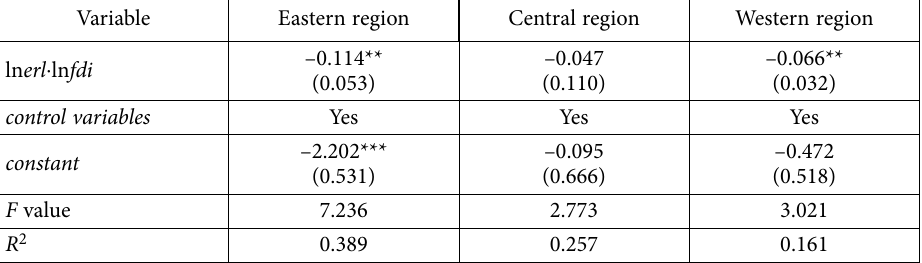
Table 9. Effect of foreign direct investment (source: The data in the table are calculated by the software of STATA)